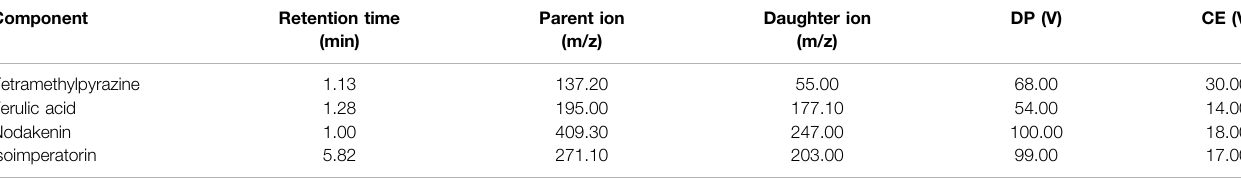
TABLE 2 | Mass spectrometry conditions of tetramethylpyrazine, ferulic acid, nodakenin, and isoimperatorin.